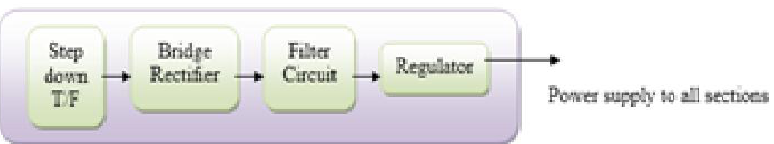
Fig. 3. Block Diagram of Power